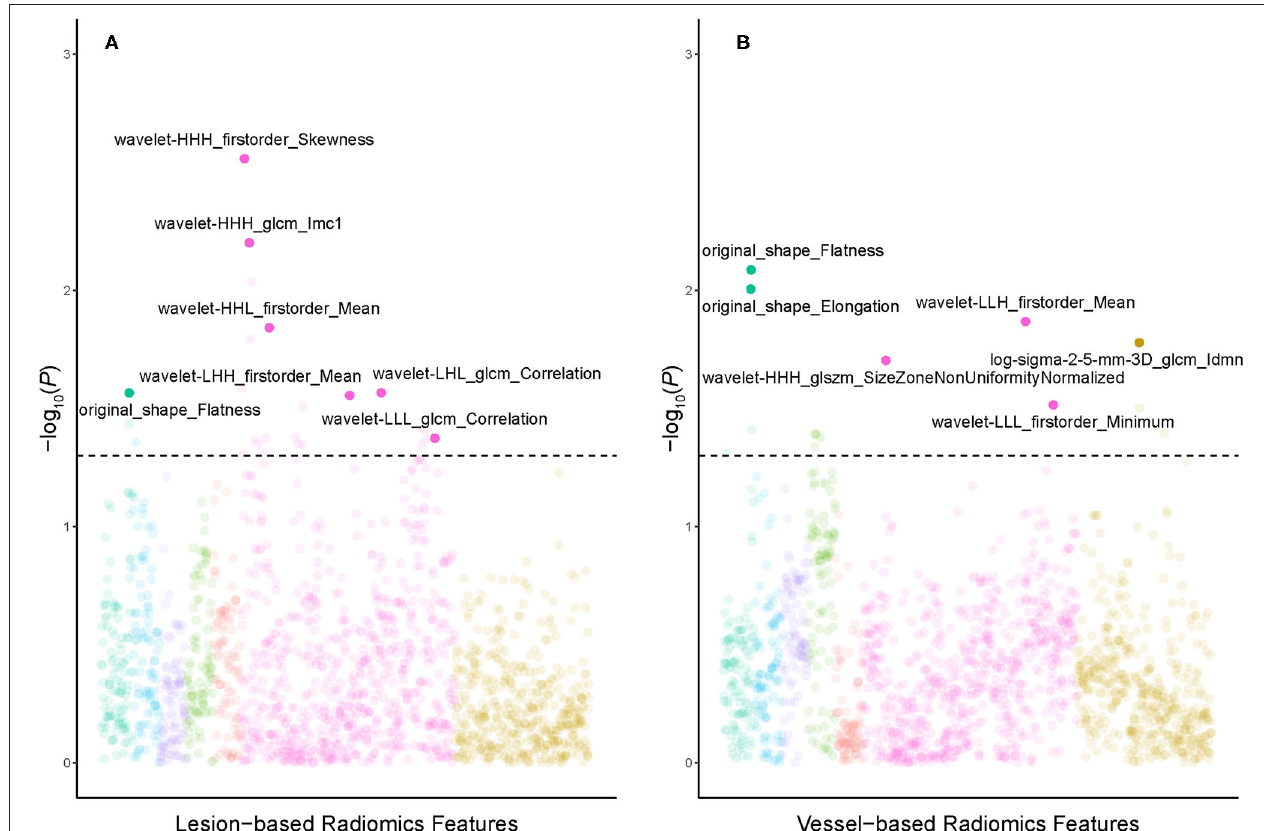
FIGURE 5 | Manhattan plots demonstrated the strength of association [–log10 ( P -value)] of univariate logistic regression] comparing PCAT radiomics features derived from lesion-based (A) and vessel-based (B) PCAT segmentation against the hemodynamic significance of coronary stenosis. Solid points above the horizontal cutoff line denote features qualified for univariate logistic regression and LASSO-logistic regression, and their corresponding feature names are displayed. LASSO, least absolute shrinkage and selection operator; PCAT, pericoronary adipose tissue.